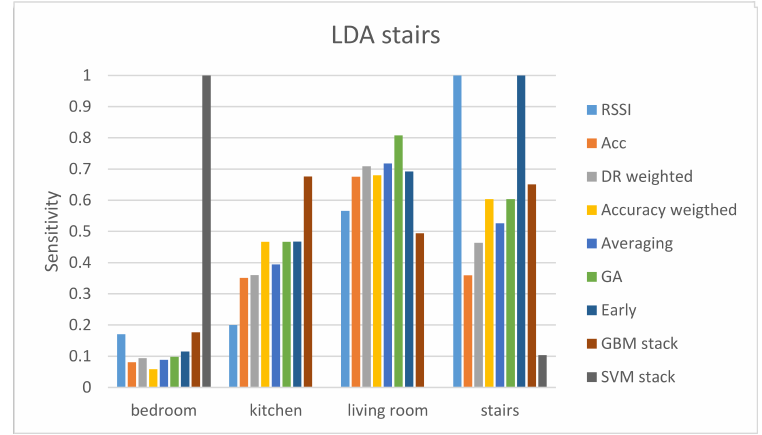
Figure 4. Sensitivity results of the LDA classifier for the stairs gateway.